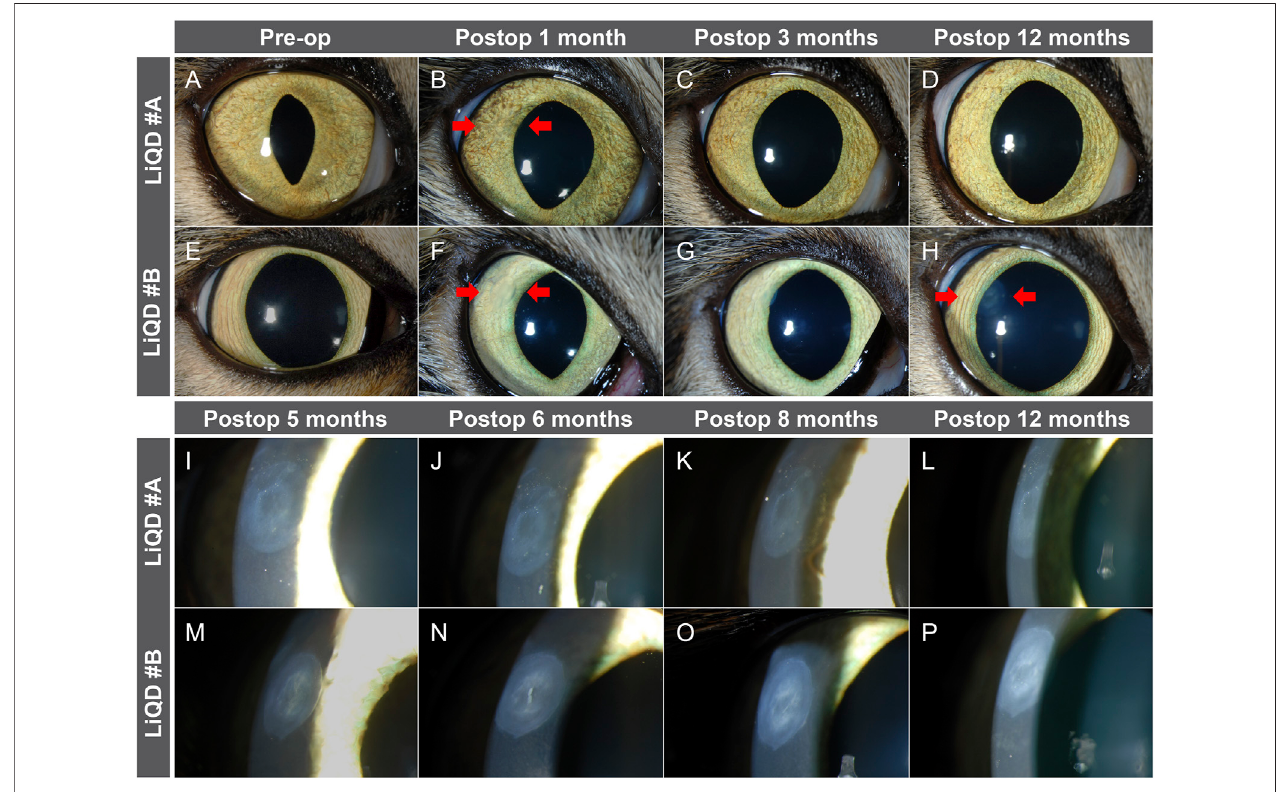
FIGURE 2 | Slit lamp examination. Direct illumination of the implanted corneas before and 1, 3, and 12 months after surgery in animal #A (A – D) and animal #B (E – H) . Tangential illumination at 5, 6, 8, and 12 months in animal #A (I – L) and animal #B (M – P) allows to highlight a mild stromal haze at the interface between the fi ller and the surrounding stroma. Arrows indicate the implanted